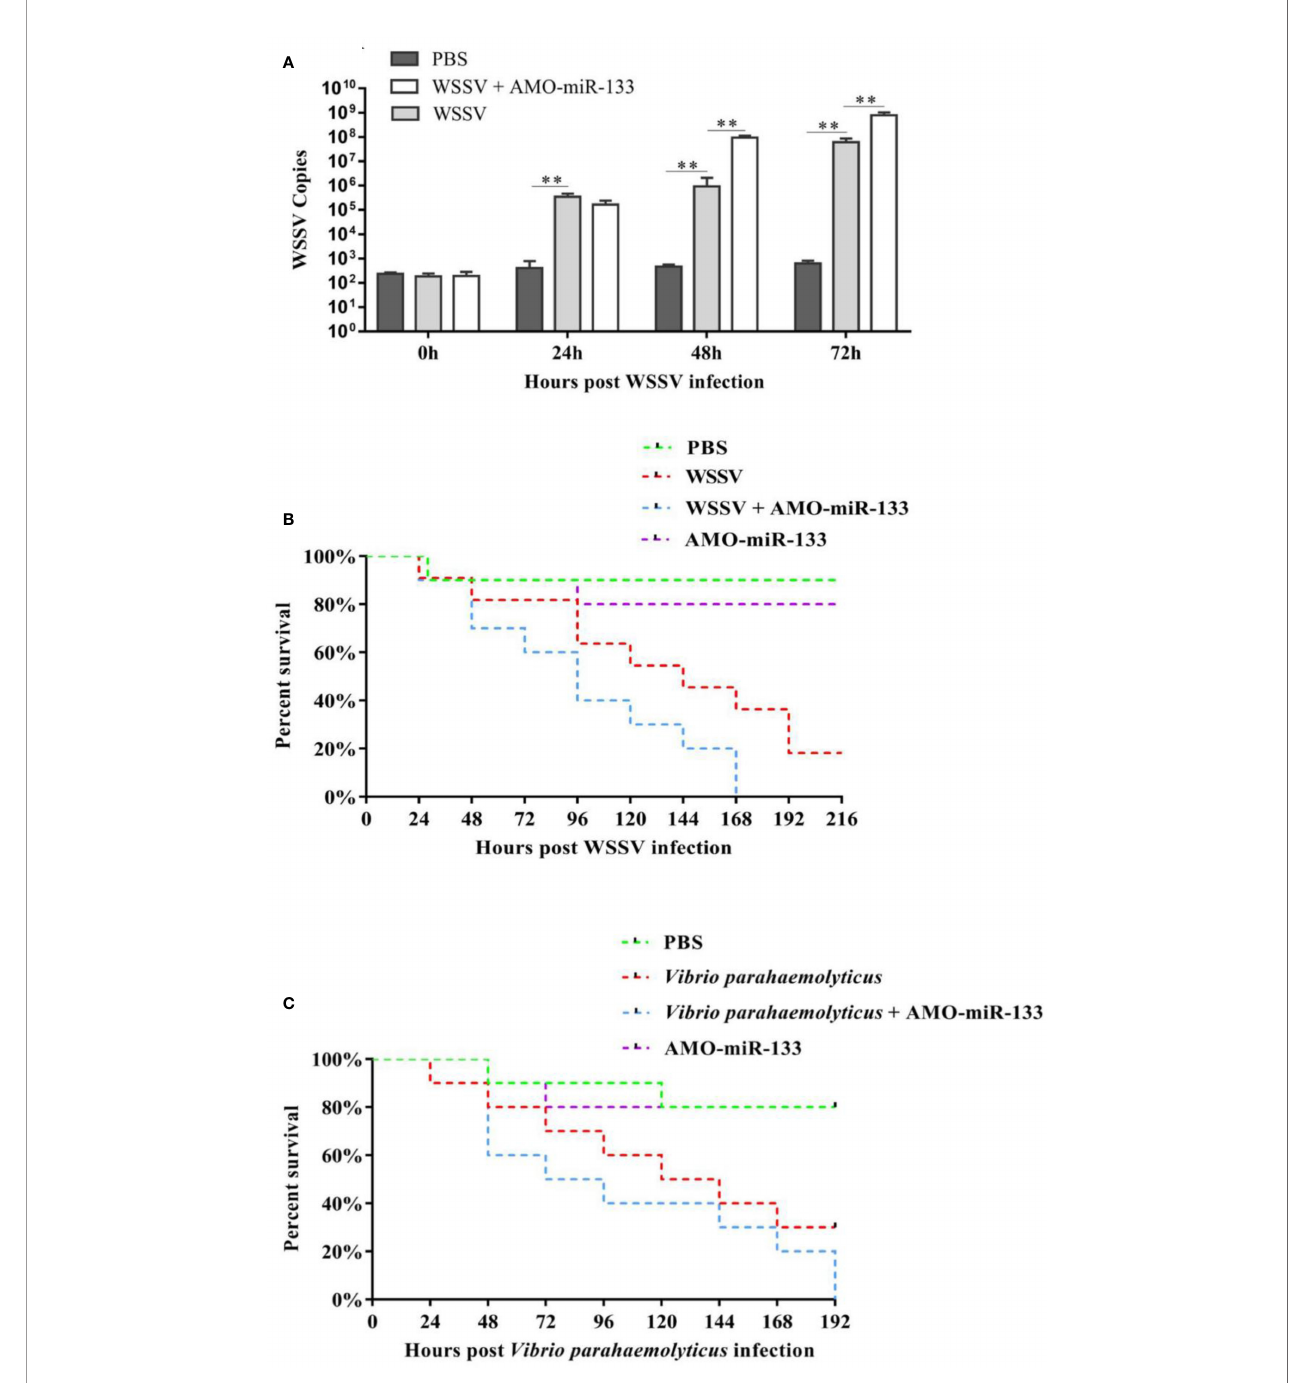
FIGURE 8 | (A) To analyze WSSV copies after WSSV challenge, hemocytes were collected at different times (0, 24, 48, 72 h) post-WSSV infection and assessed using RT-qPCR. (B) Cumulative mortality of WSSV- or (C) V. parahaemolyticus -challenged S. paramamosain treated with AMO-miR-133. Each group contained 10 individuals. Signi fi cant difference between different samples is indicated by ** P <